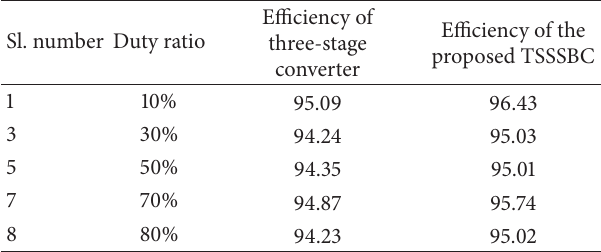
Table 6: Comparison of three-stage converter and TSSSBC. Sl. number Duty ratio